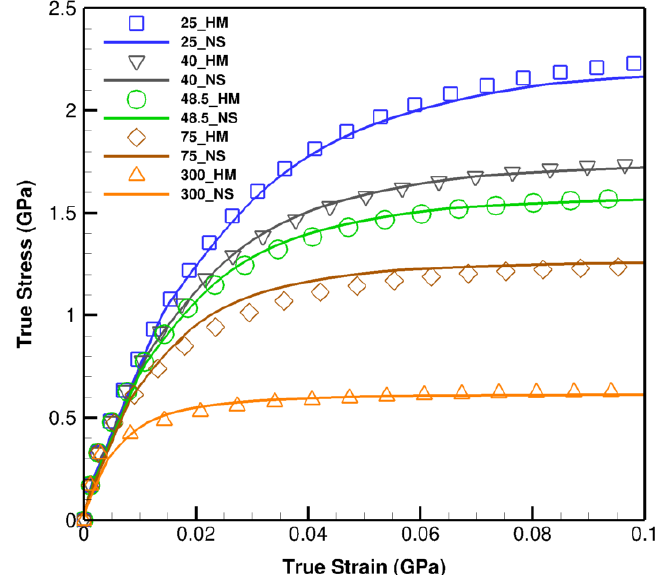
Figure 8. The comparison of the results obtained through the homogenized and nano-scale size- dependent constitutive model on 25 nm, 40 nm, 48.5 nm, 75 nm, and 300 nm Cu/Nb laminates. Symbolic points denote homogenized (HM) and solid lines the nano-scale (NS) model